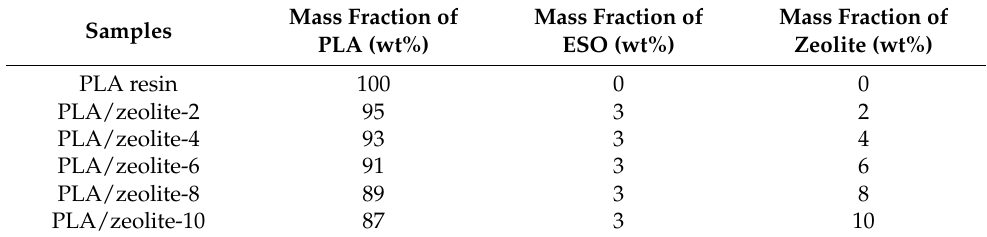
Table 1. Experiment recipe.